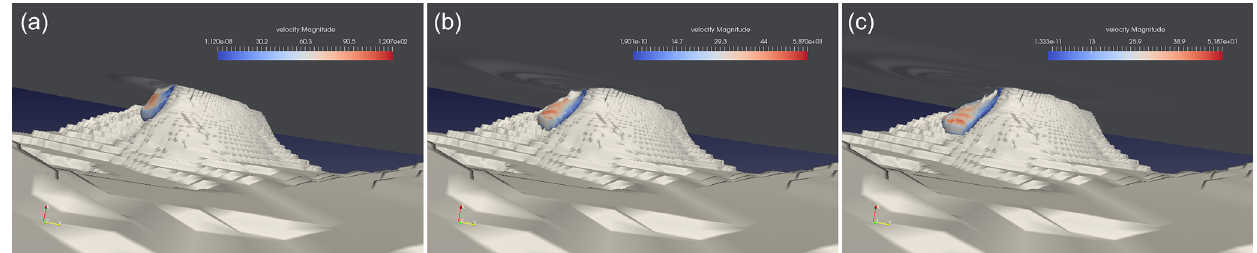
Figure 11. THETIS 3D computations for 80km 3 slide volume. Snapshots of a 0.1 slide volume fraction contour colored by velocity magni- tude at t = 102s (a) , 230s (b) and 342s (c) . Slide viscosity is 2 × 10 7 Pas.